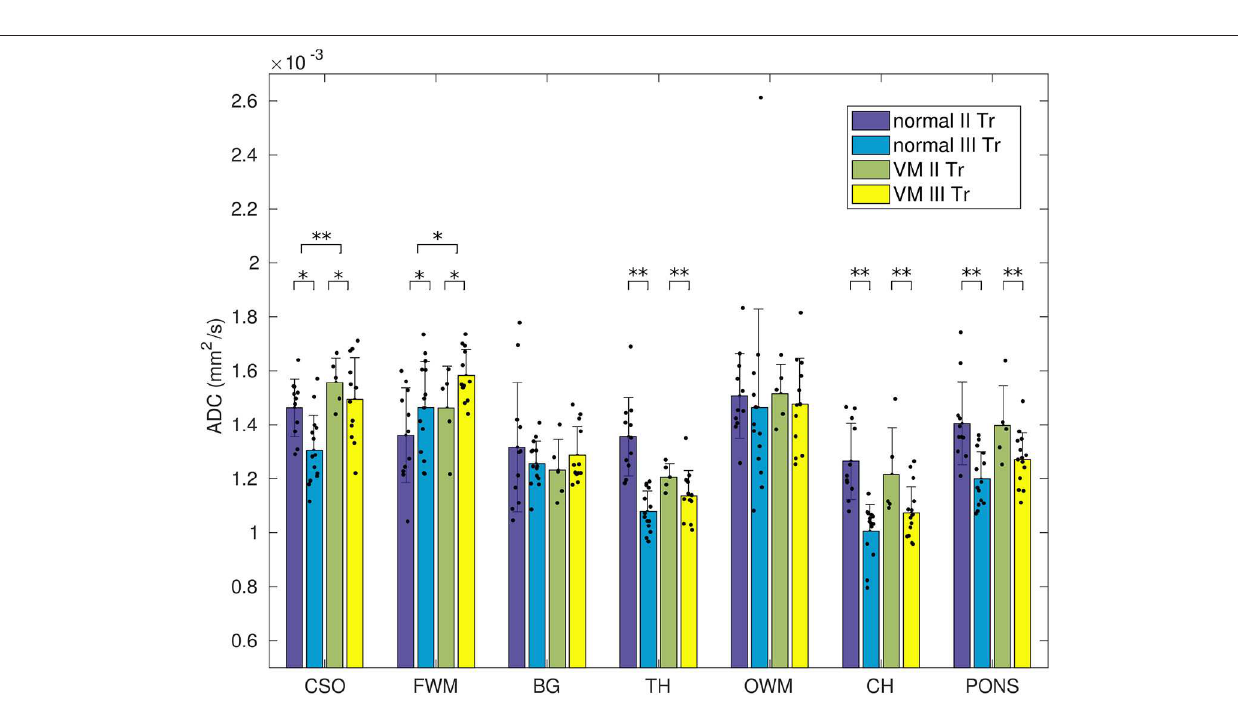
FIGURE 3 | ADC measurements in normal and VM brains of fetuses in the second and third trimester of gestation. Dots represent the ADC calculated for each subject and asterisks represent the p -value of multi-way ANOVA (* p < 0.02; ** p < 10 − 3